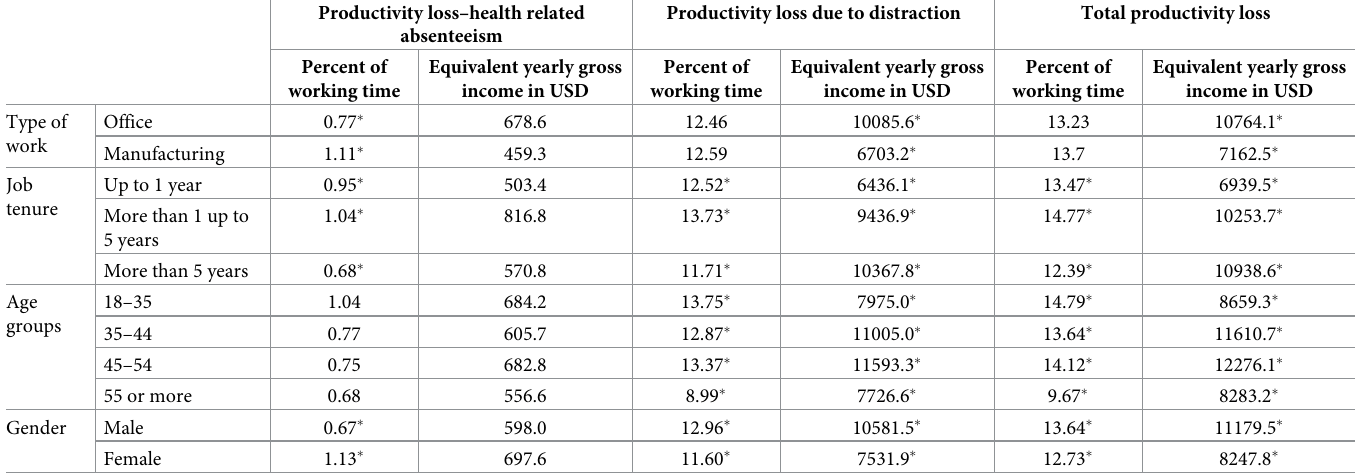
Table 2. Average productivity loss and average cost of productivity loss by work type, job tenure, gender and age group–primary analysis of a US manufacturing company.